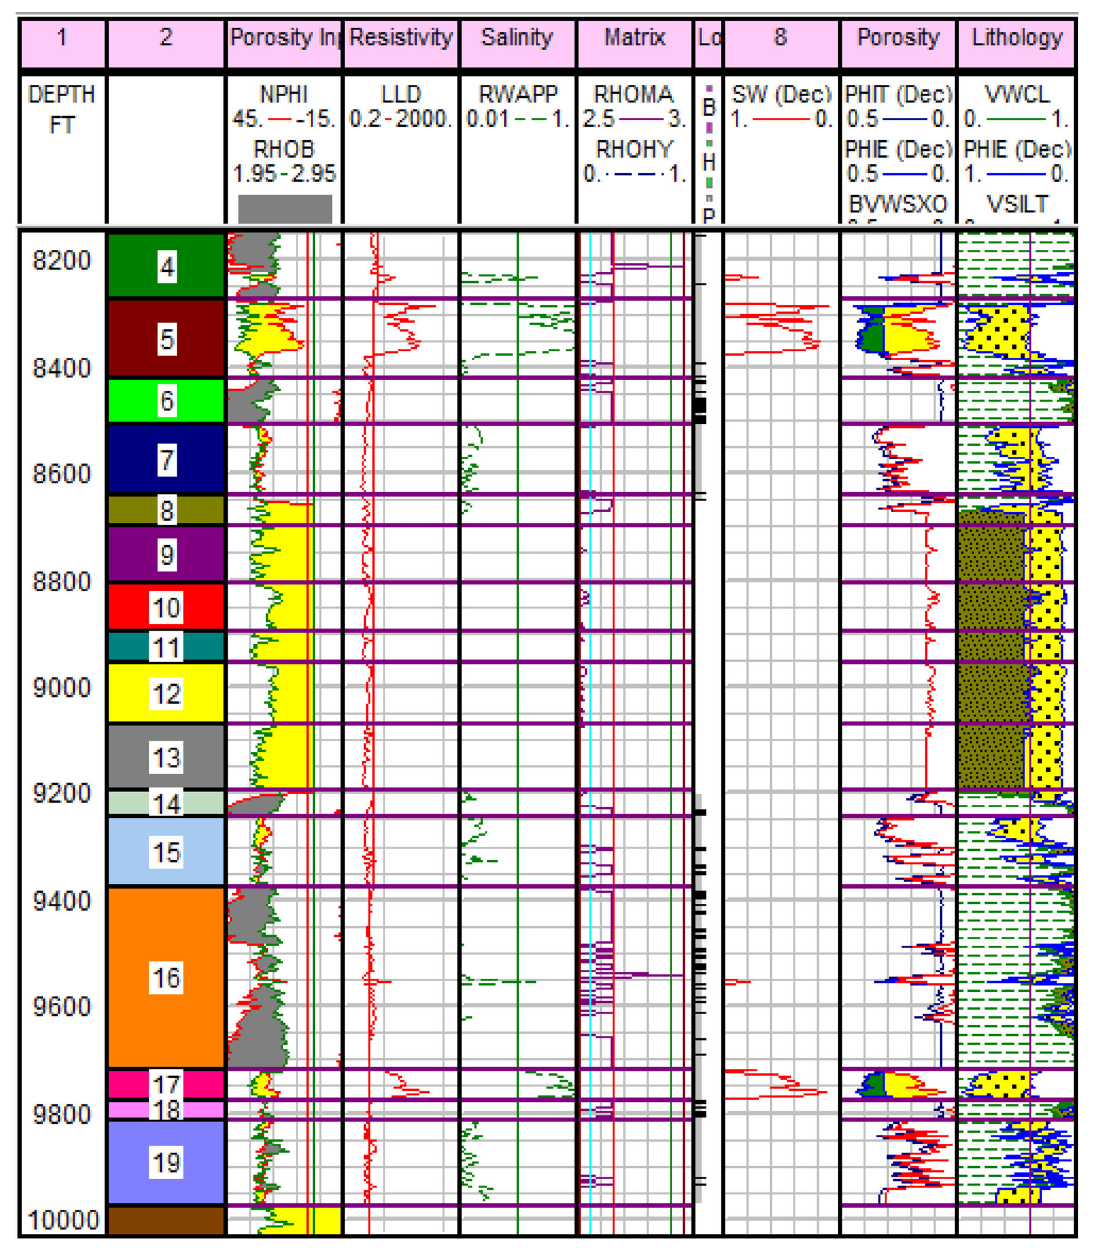
Fig. 6 Estimated porosity, water saturation and fluid types present in JAP-1